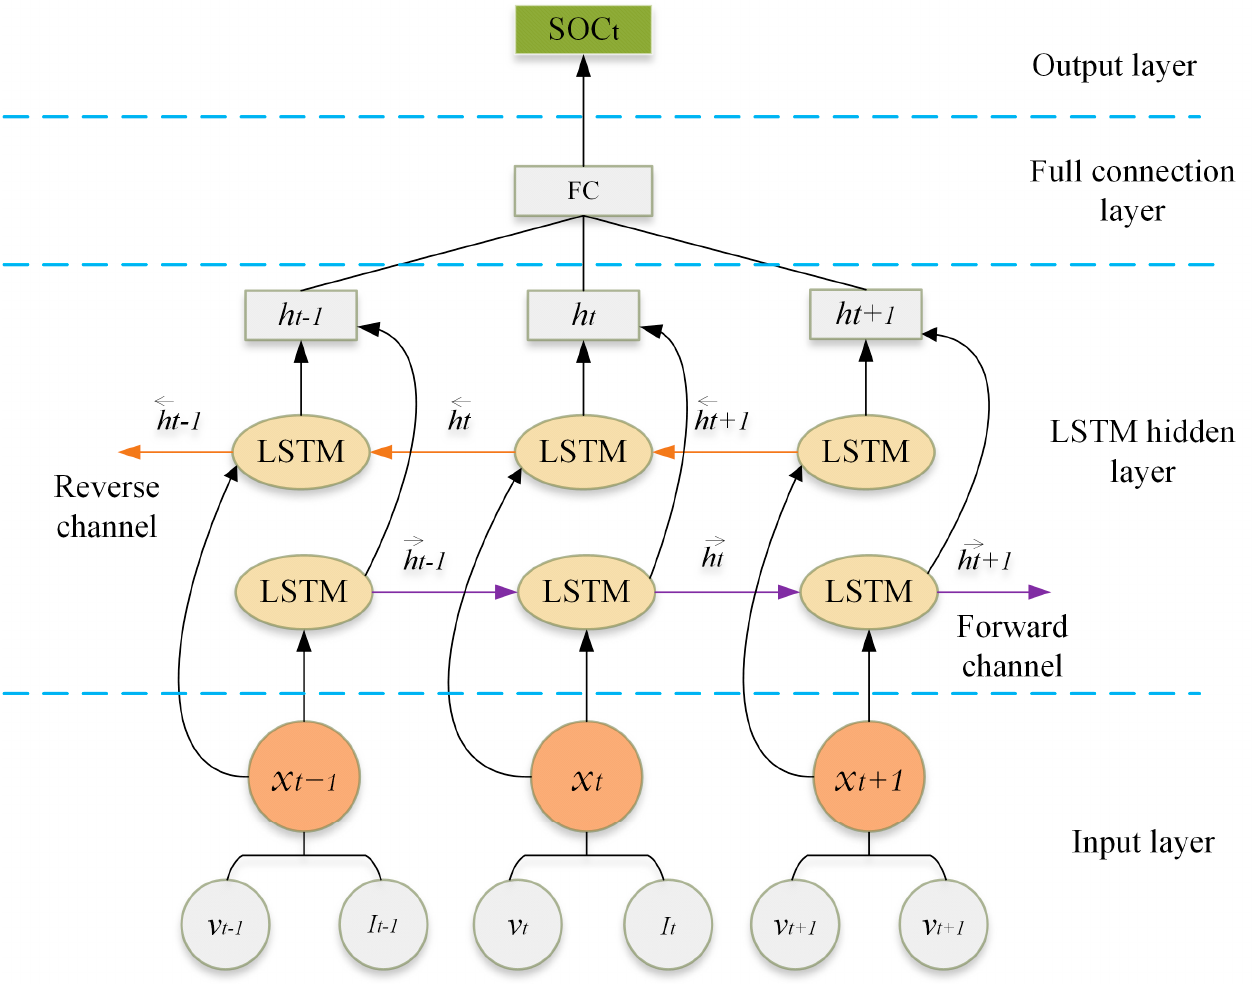
Figure 2. Structure of the BiLSTM network.